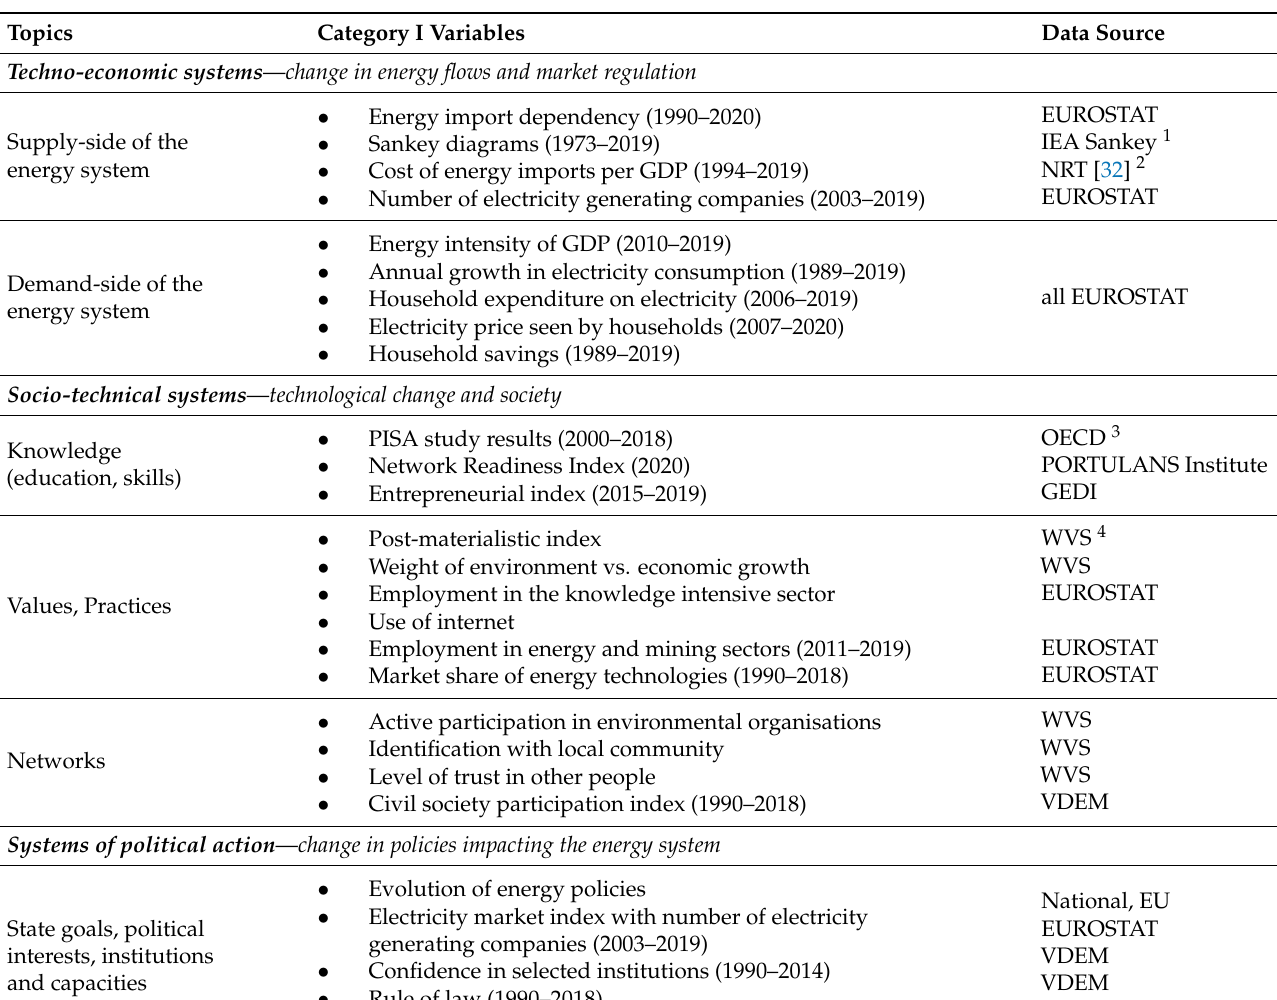
Table 1. Overview of variables and sources for Data category 1. The three co-evolving systems as well as the topics are based on Cherp et al. [21] and Inglehart 2014. For abbreviations, see Appendix